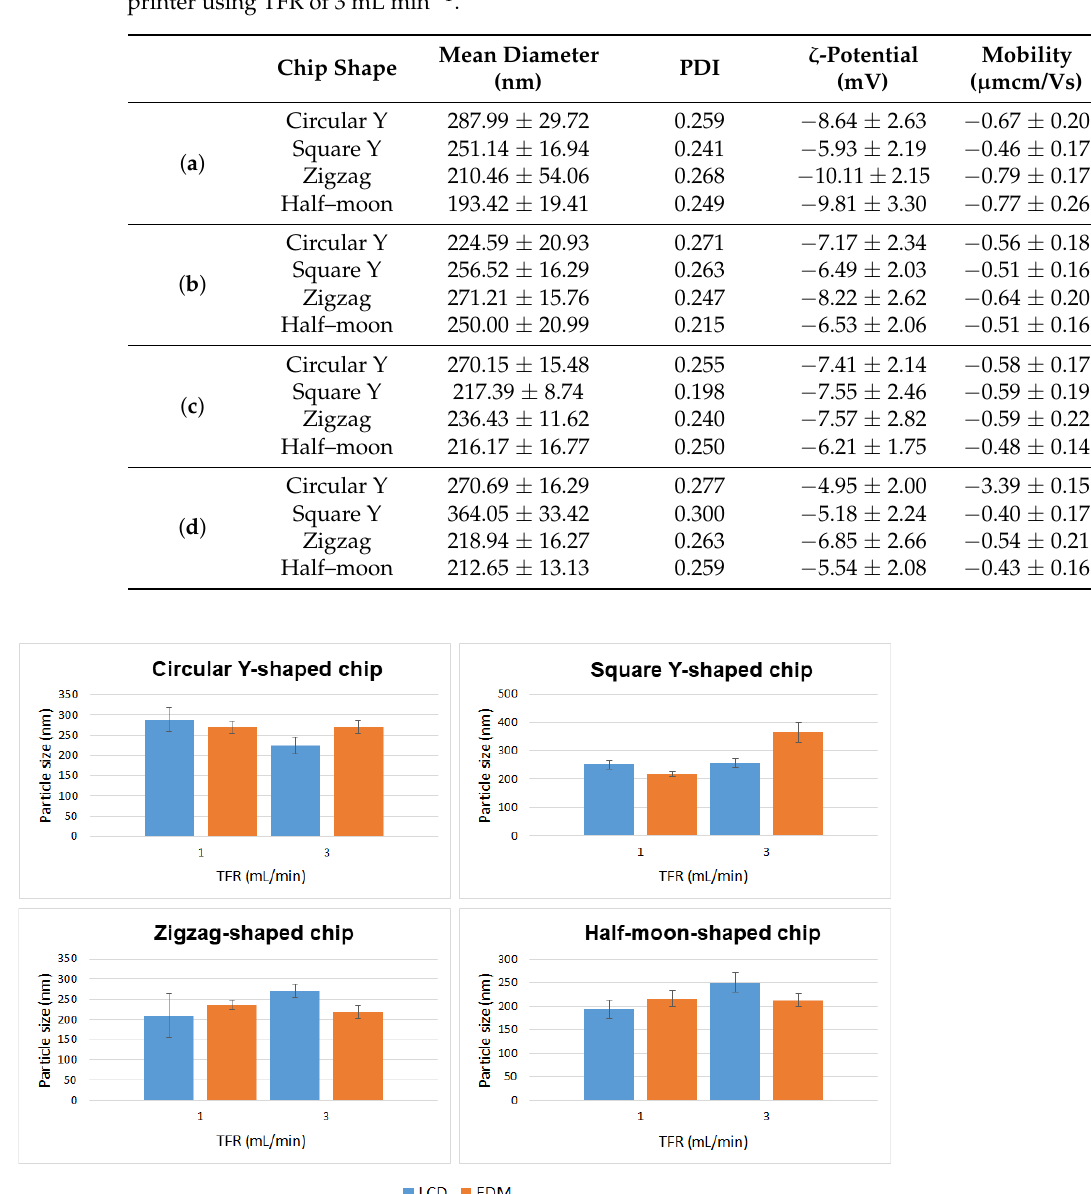
Table 1. Mean particle size, polydispersity index (PDI), ζ -potential, and mobility of liposomes prepared using circular Y-shaped, square Y-shaped, zigzag-shaped, and half-moon-shaped chips